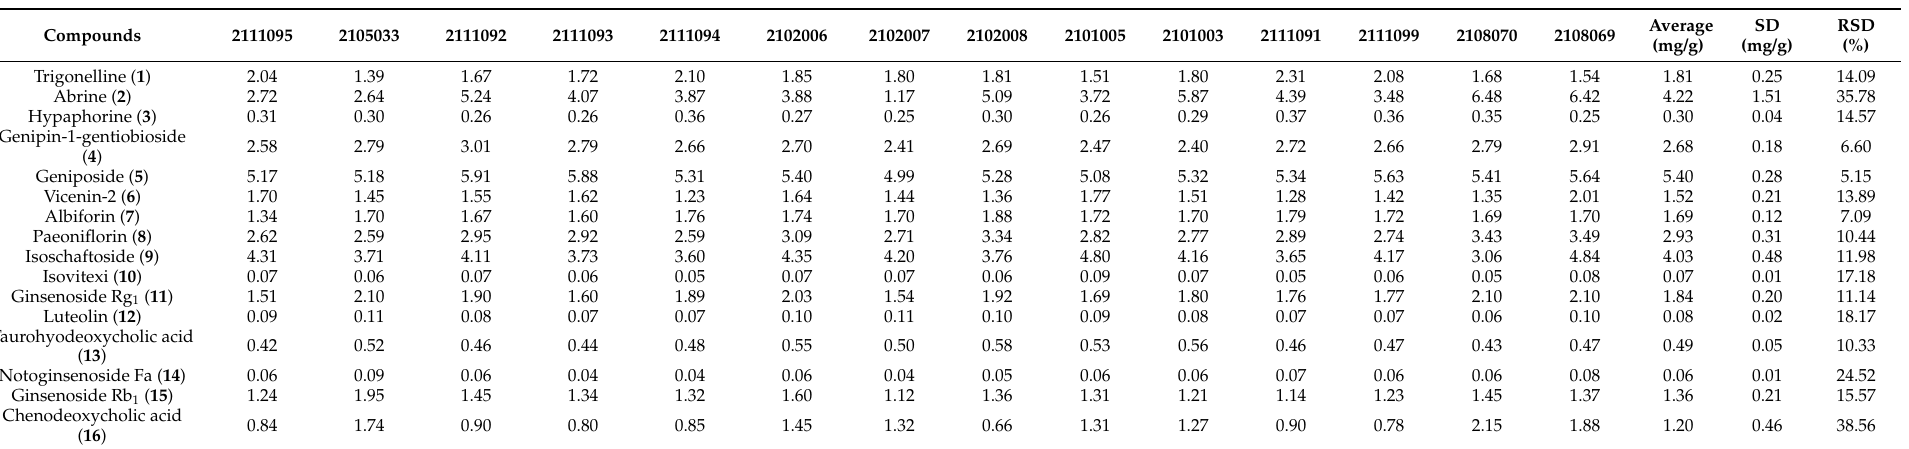
Table 4. Determination results of JGCC in 14 different